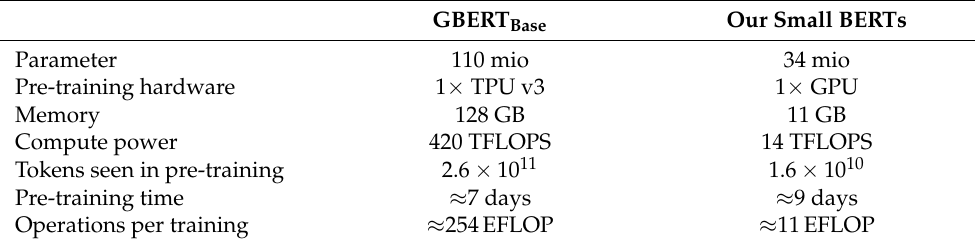
Table 12. Comparison of some technical attributes between GBERT Base (from [13]) and our small BERTs. The operations per training is a coarse estimation based on the theoretic compute power and pre-training